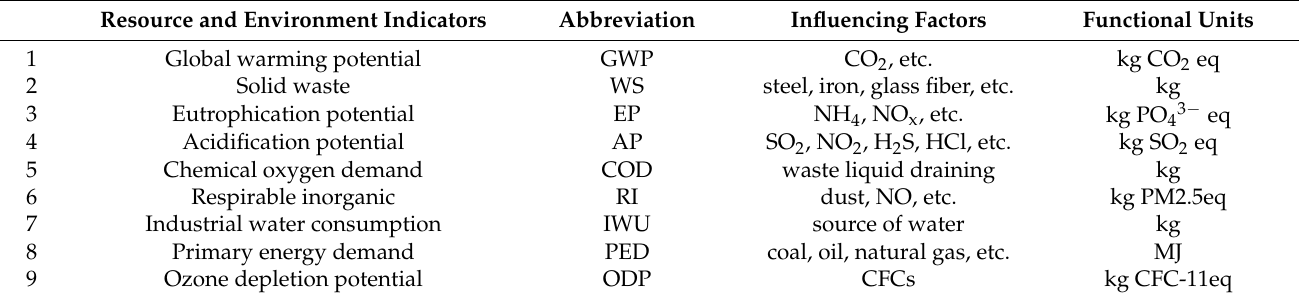
Table 4. Main influencing factors and functional units of resources and environmental indicators.